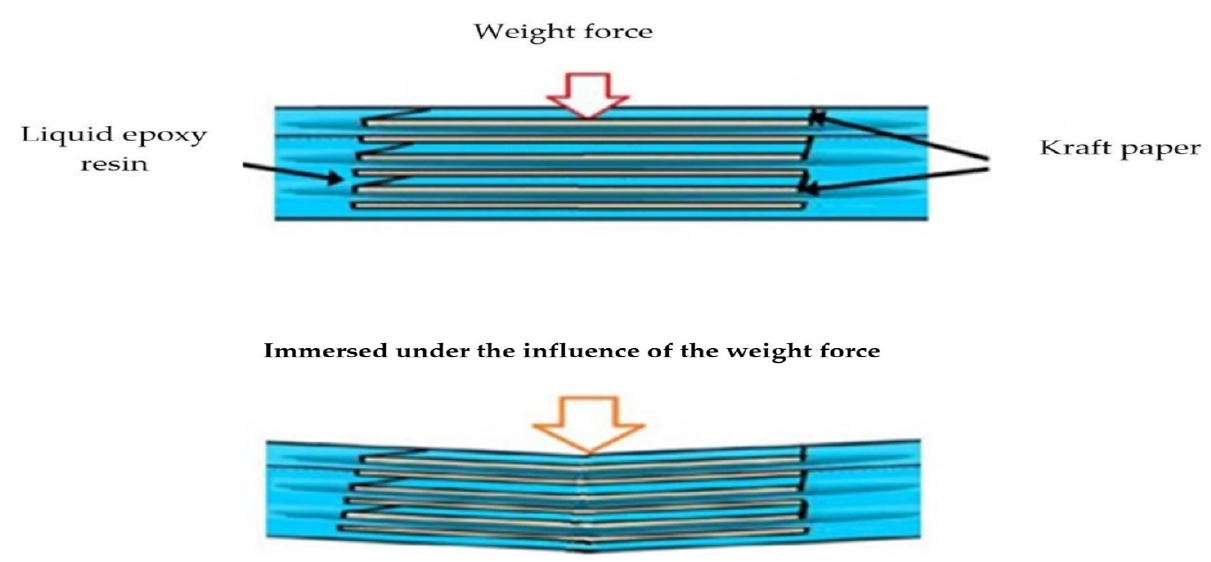
Figure 3. Schematic representing the effect of using kraft paper as separating layers in epoxy.